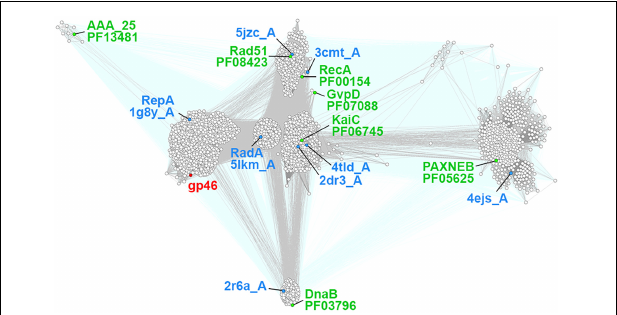
FIGURE 1 | Sequence clustering of GP46 F 13 and the closest protein families. Each point represents one protein sequence. Protein sequences used as queries for collecting family members are marked with green dots and sequences of proteins of known structures with blue ones. Lines representing mappings with P -values lower and higher than 1E-15 are drawn in gray and teal, respectively.